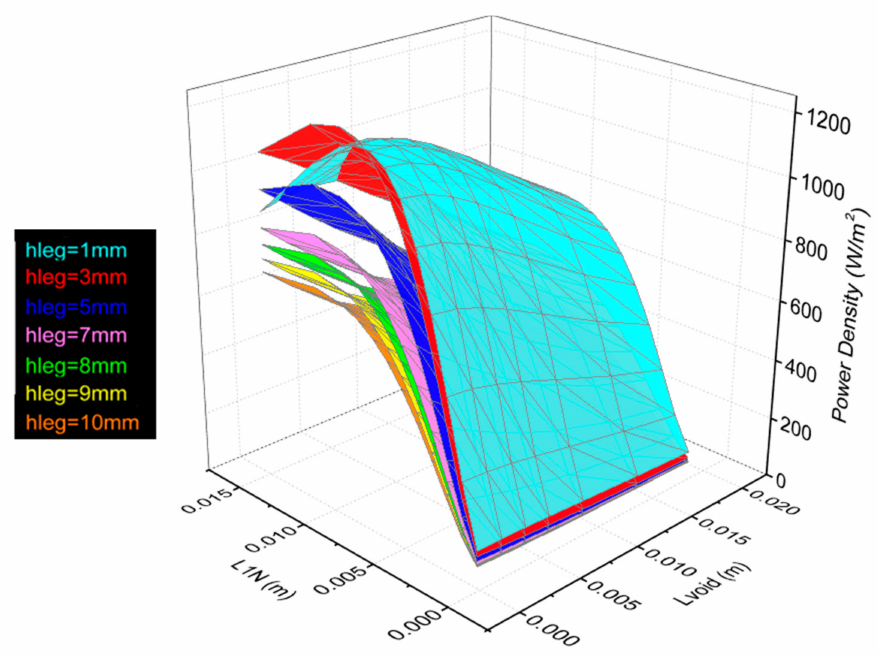
Figure 16. Matched power density as a function of n-type diameter, L 1 N , and element spacing, L void , for several element thicknesses, h leg .